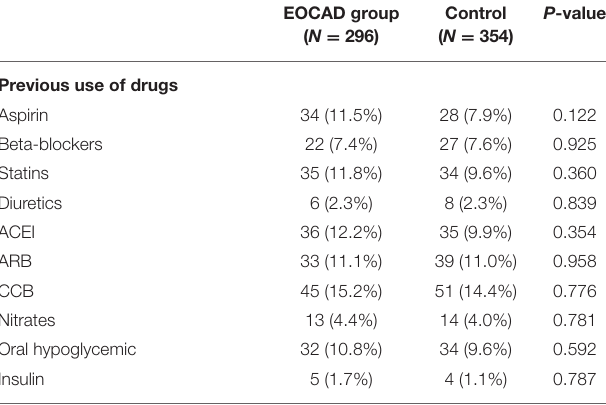
P-values were estimated from t-test for continuous variables and chi-square test for categorical variables. LVSED, left ventricular end-systolic dimension; LVDED, left ventricular end-diastolic dimension; LVEF, left ventricular ejection fraction; HgB, hemoglobin; NLR, neutrophil to lymphocyte ratio; RDW, red cell distribution width; PDW, platelet distribution width; ALT, alanine transaminase; Crea, serum creatinine; eGFR, estimated glomerular filtration rate calculated by the abbreviated MDRD equation; UA, uric acid; CPR, C reative protein; HbA1c, glycosylated hemoglobin; TC, total cholesterol; TG, triglycerides; LDL-C, low-